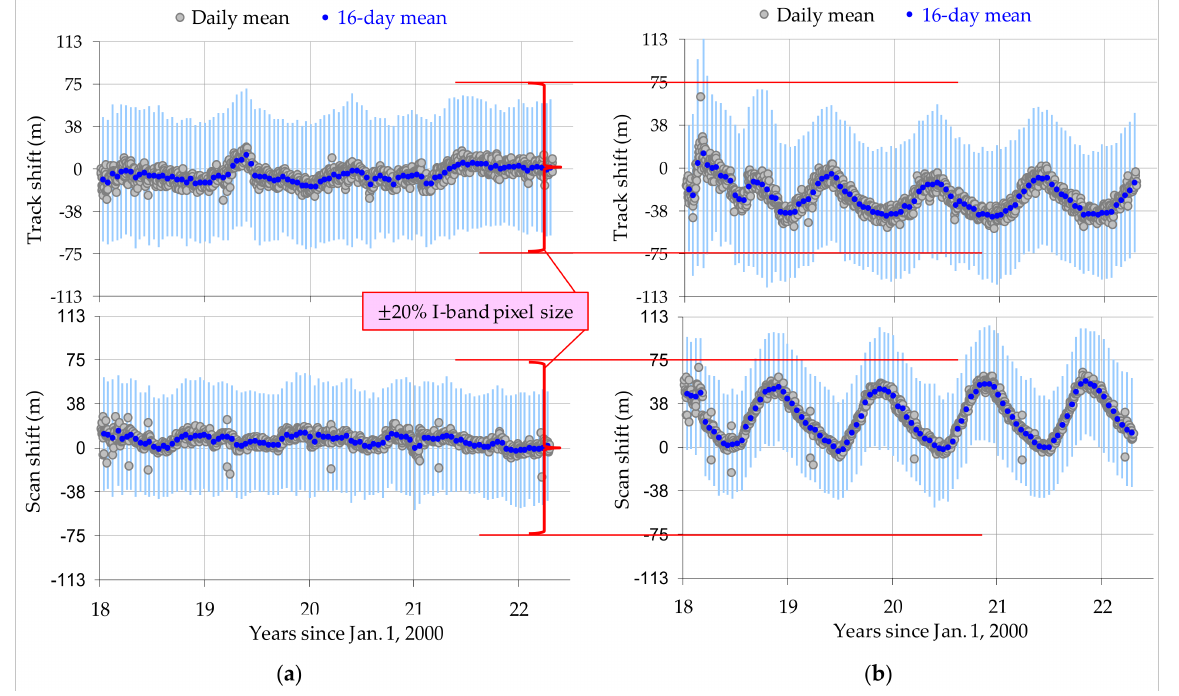
Figure 6. Measured NOAA-20 VIIRS geolocation performance in Collection-2.1 in daily means, 16-day means, and 16-day uncertainties. ( a ) Detected from the operation geolocation data products; ( b ) what the performance would be without temporal pointing correction.